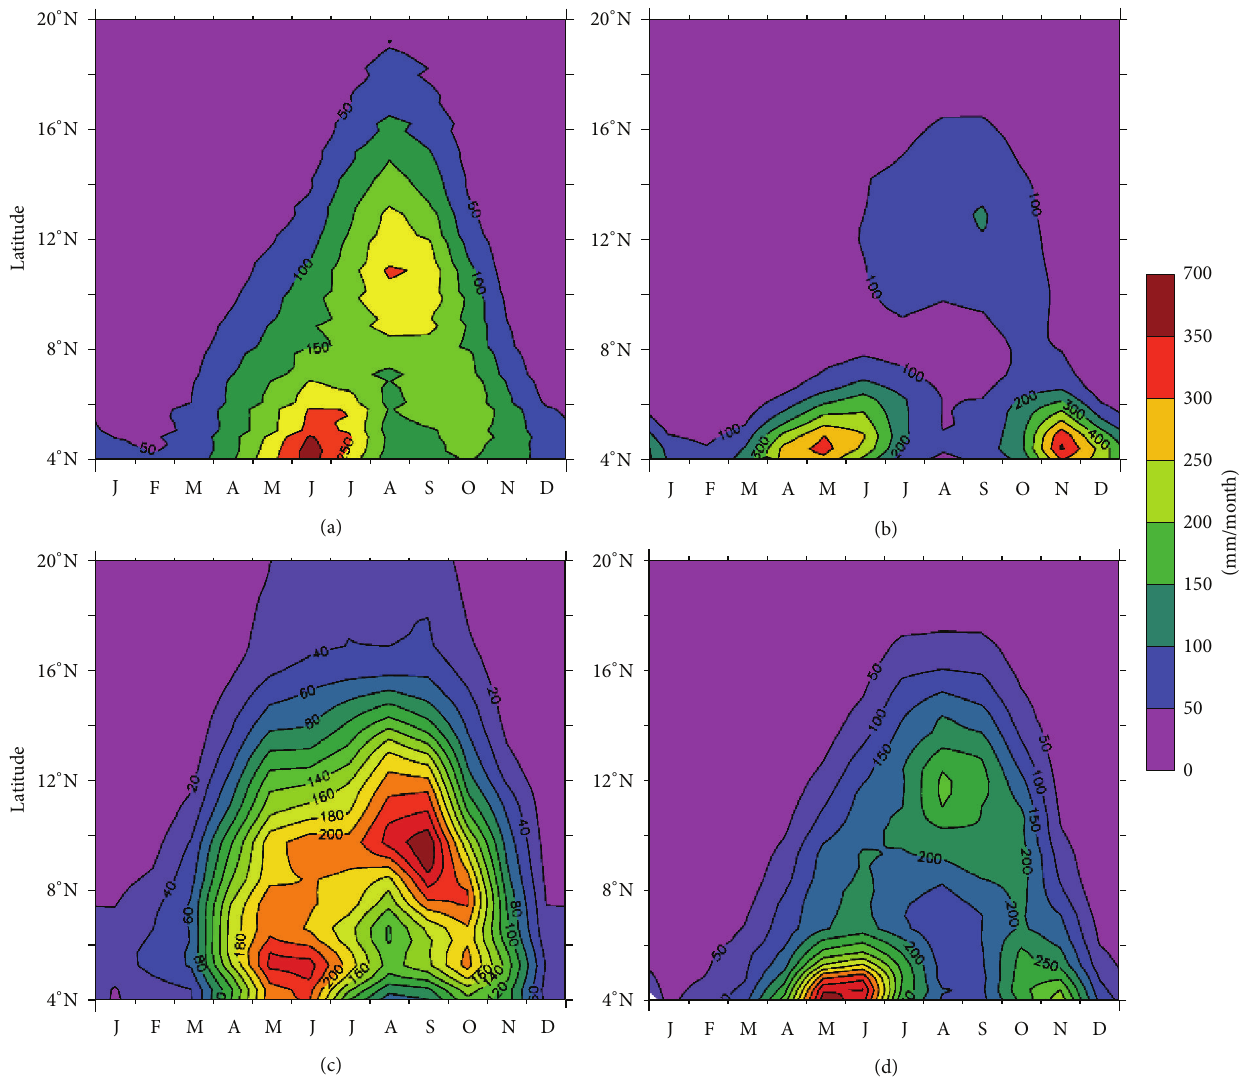
Figure 5: Time-latitude cross section of mean monthly rainfall (mm/month) for (a) TRMM, (b) CCLM, (c) RCA, and (d) REMO from 1998 to 2008 averaged over longitude 10W to